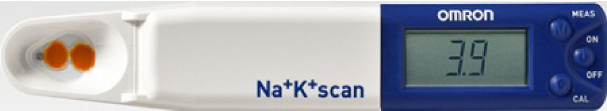
Figure 2. Self-monitoring device used in the randomized trial. Portable handy-sized urinary Na / K ratio